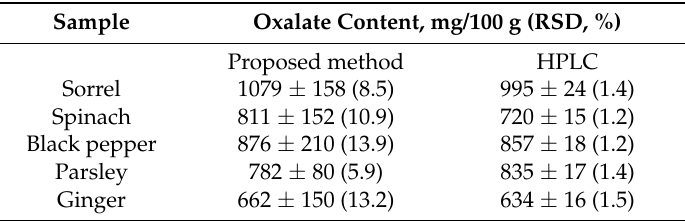
Table 5. Solid spectrophotometric (Si-Ti/ECR) and HPLC determination of oxalate in food samples ( n = 3, P =